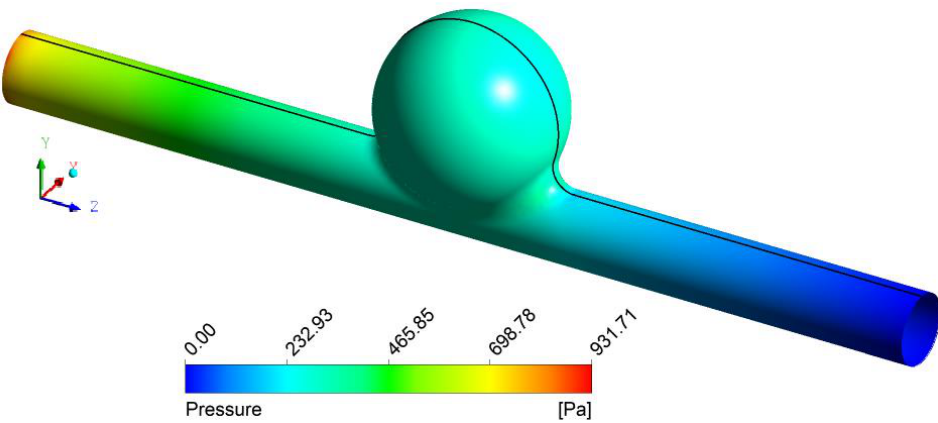
Figure 11. Wall pressure distribution for Carreau model and u = 888 mm/s.